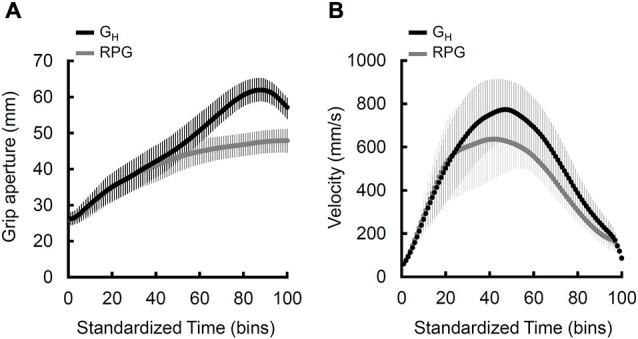
Normalized grand mean grip aperture and velocity profiles for the natural grasps (black) and real-time pantomime grasps. (A) Grip aperture normalized to 100 time bins for qualitative comparisons. Note that, overall, the real-time pantomime grasps lack a distinct peak and achieve lower grip aperture values than the natural grasps. The error bars reflect average within-participant standard deviations (B) Velocity of the wrist normalized to 100 time bins for qualitative comparisons. Note that, overall, the displaced-pantomime grasps appear to be executed more slowly than the natural grasps. The error bars reflect the between-participant standard deviations.